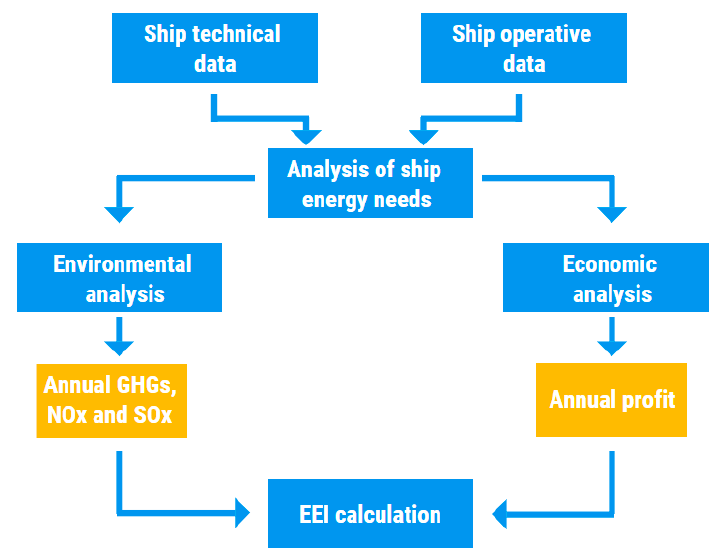
Figure 2. The methodology flowchart.